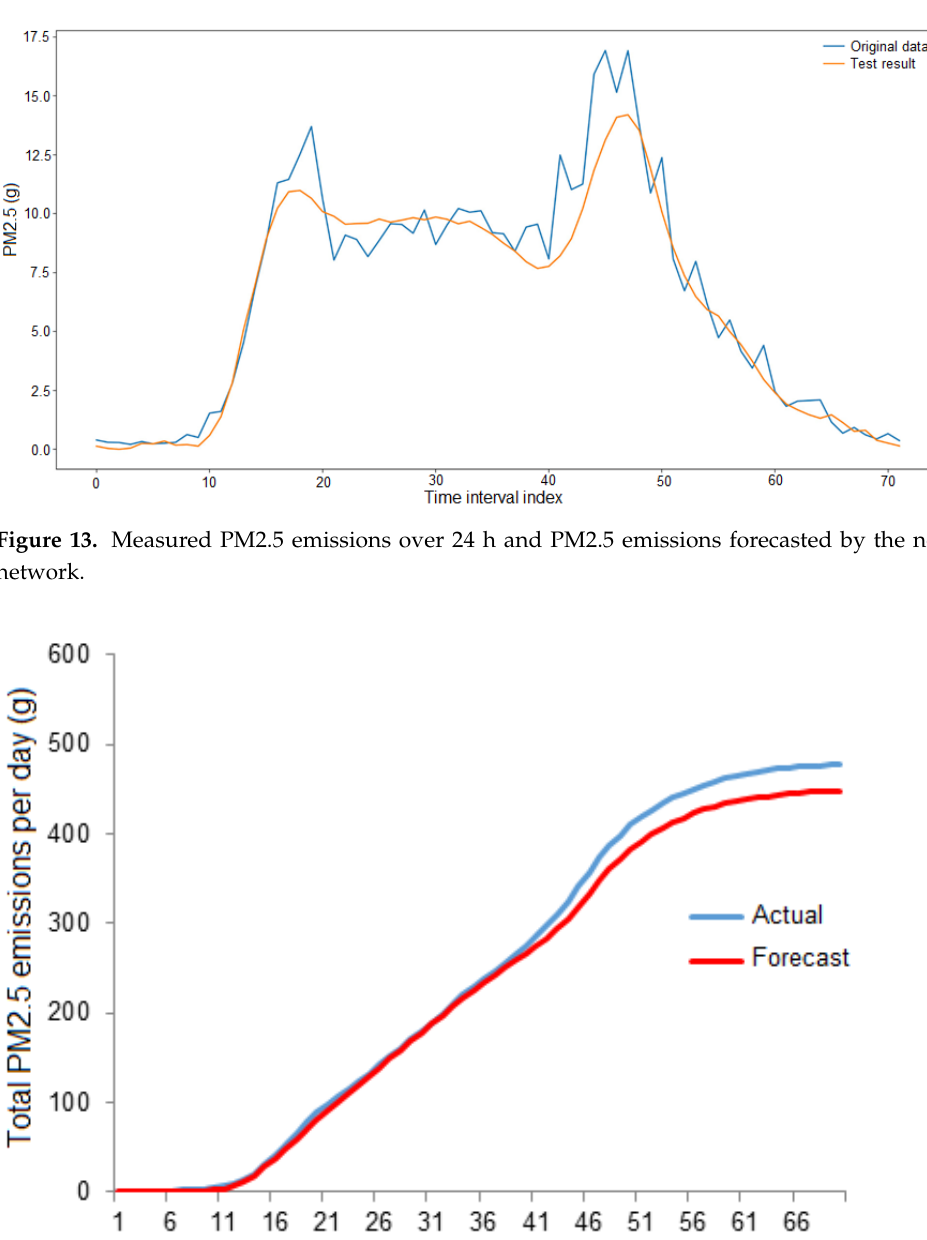
( b ) Figure 12. Distribution fields: ( a ) for the mean square error mse of calculating the amount of PM2.5 emissions; ( b ) for the training time of a four-layer neural network. Configuration 24, with three layers and 1200 neurons in each layer ( mse = 0.081; time = 527 s) showed the minimum mse errors. However, this configuration spends too much time on learning and operation. Configuration 29, with four layers and 600 neurons in each layer ( mse = 0.083; time = 212 s) is one of the most optimal. It produces predictions with nearly the same quality as Configuration 1, but 2.5 times faster. Statistical analysis of the forecasting accuracy ( mse ) of various network configura- tions showed that the area of significant differences begins with errors of more than 0.108 (Pearson’s nonparametric chi-square test). Fifteen out of the thirty-two tested configura-